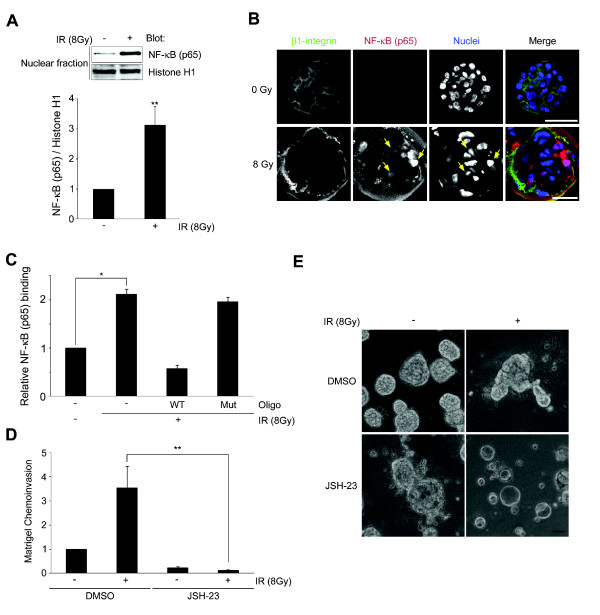
Invasive phenotype emerged in a sub-population of irradiated MCF10A-Akt cells are associated with nuclear translocation of NF-κB. (A) On Day 30 cultures, immunoblotting of nuclear fraction shows up-regulated nuclear translocation of NF-κB p65 in the 8 Gy IR cultures. The intensities of NF-κB were normalized with nuclear protein, Histone H1 (**, P < 0.01, n = 4). (B) IF images of confocal microscopy show β1-integrin (green), NF-κB (red) and nuclei (blue). Bar = 50 μm. (C) The binding of NF-κB to the β1-integrin promoter region is up-regulated in MCF10A-Akt cells that survived after exposure to radiation (WT, wild-type, Mt, mutated oligonucleotide; n = 3, *, P < 0.05). (D-E) The NF-κB inhibitor, JSH-23, was added from day 0 of the second three-dimensional cultures. IR-induced chemoinvasion activity, which was inhibited by NF-κB inhibitor, JSH-23. Bar = 50 μm. IF, immunofluorescence; IR, ionizing radiation; NF-κB, nuclear factor-kappaB; TUNEL, terminal deoxynucleotidyl transferase-mediated dUTP nick end labeling.